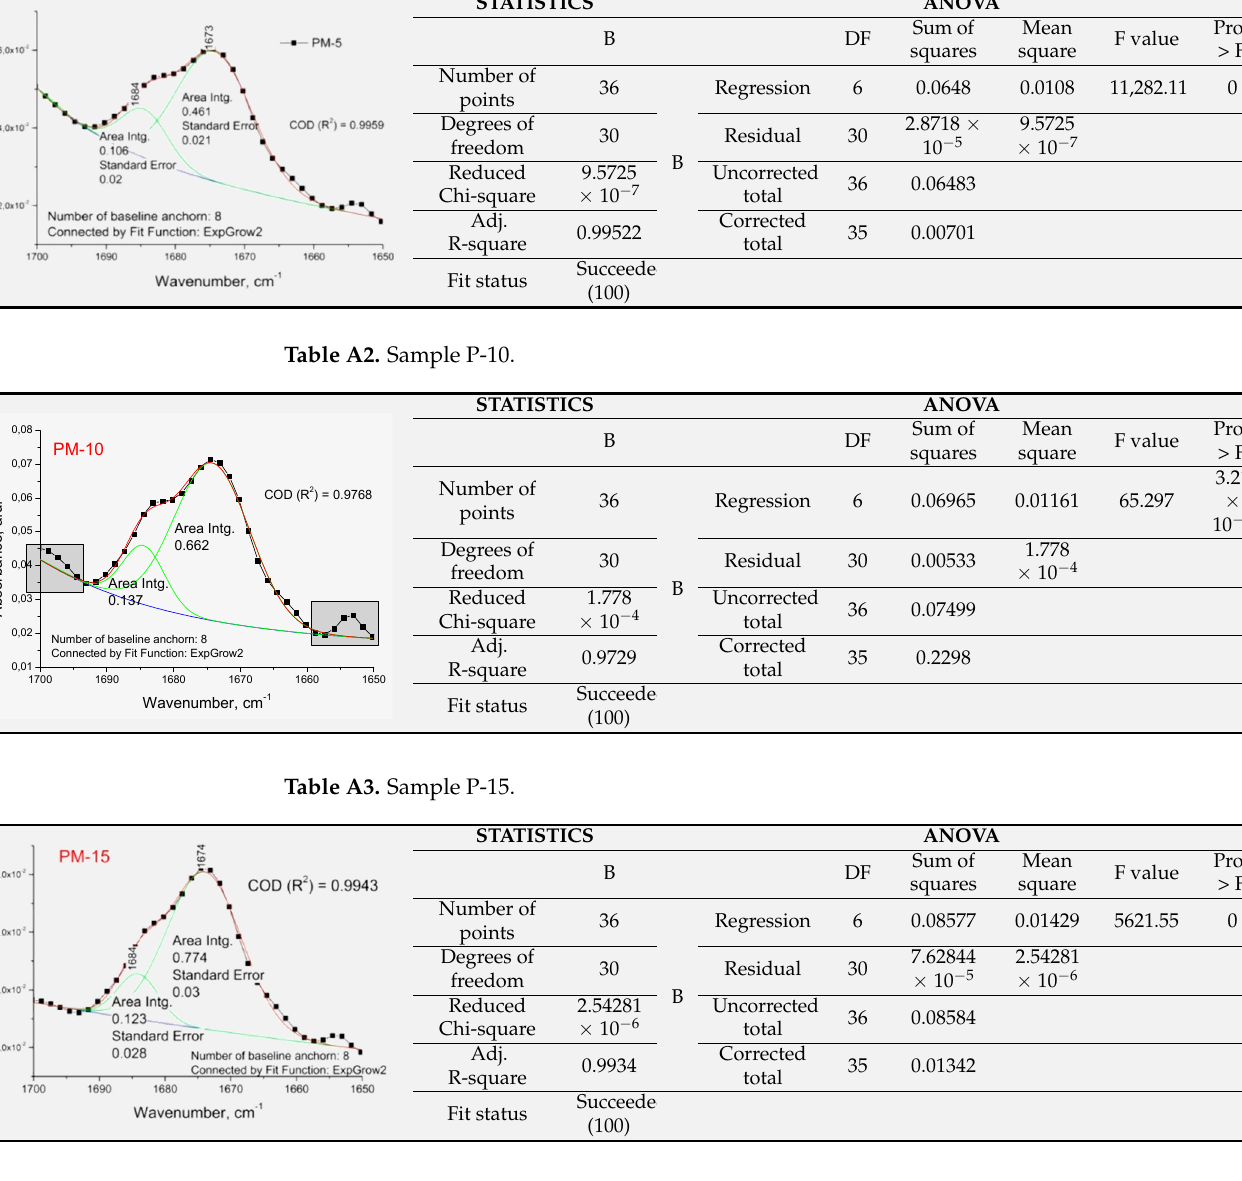
Table A4. Sample